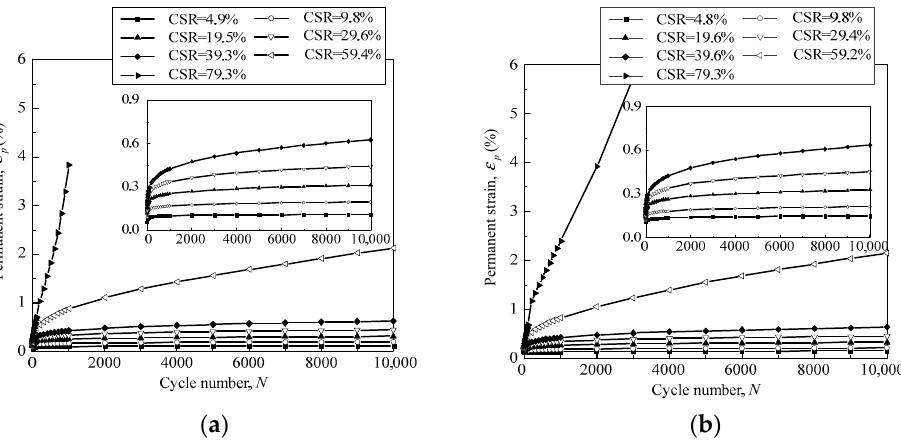
Figure 6. The relationship between permanent strain and loading cycles of granular samples with DoC = 0.95 under the confining pressure of ( a ) 40 kPa; and ( b ) 60 kPa.